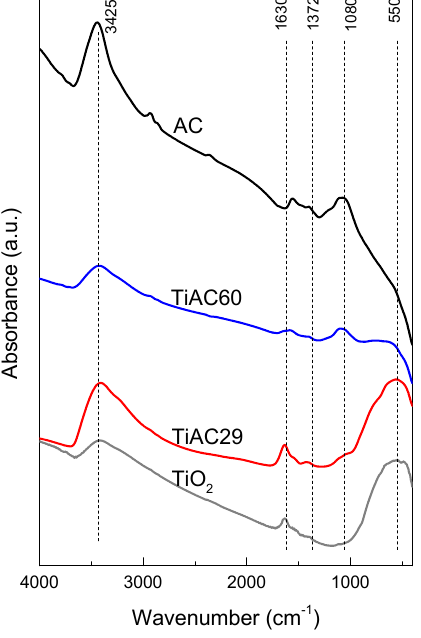
Figure 7. FTIR spectra of AC, TiO 2, and TiACX